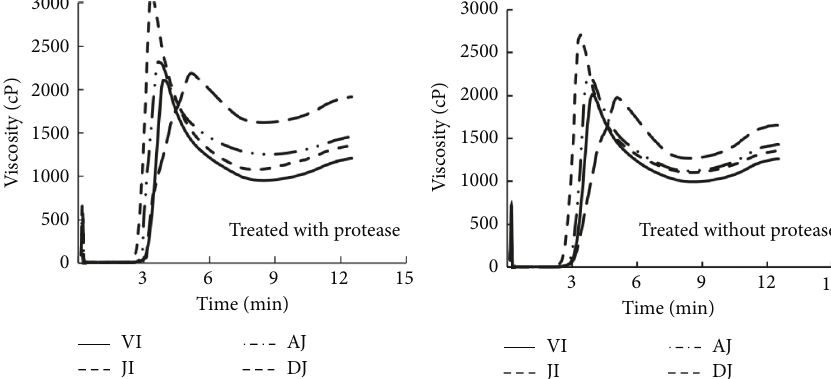
Figure 2: Pasting curves of AgNO 3 -treated waxy rice flours with or without protease. Vietnam indica (VI); Jiangxi indica (JI); Anhui japonica (AJ); Dongbei japonica (DJ).